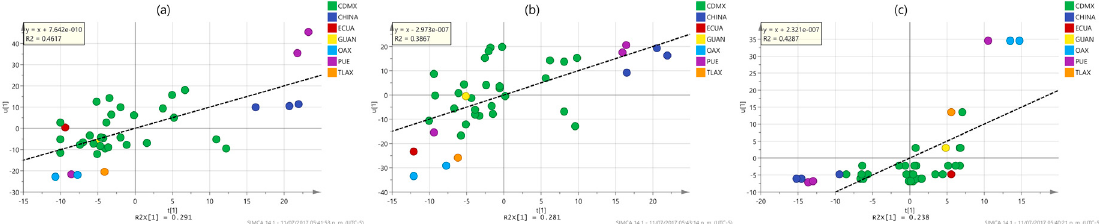
Figure 3. Inner relationship plots for the X-scores (u-data) and Y-scores (t data) between the first latent variables of the PLS models for ( a ) flavonoid content; ( b ) antioxidant (DPPH) content; and ( c ) antimicrobial S. mutants MIC activity, labeled according to their origin: Mexico City (CDMX), Puebla (PUE), Oaxaca (OAX), Guanajuato (GUAN), Tlaxcala (TLAX), Ecuador (ECUA) and China (CHINA). Inside the figures the lineal regression equation and determination coefficient value of the data are reported.